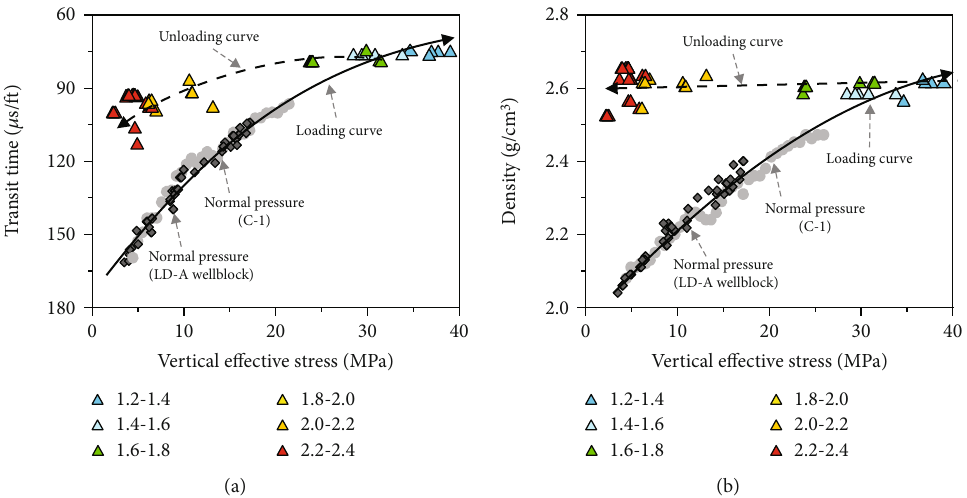
Figure 8: (a) Vertical e ff ective stress versus sonic transit time crossplots and (b) vertical e ff ective stress versus density crossplots for the LD-B Wellblock in the Yinggehai Basin. The loading curve is constructed by the normal pressure of well C-1 and the LD-A